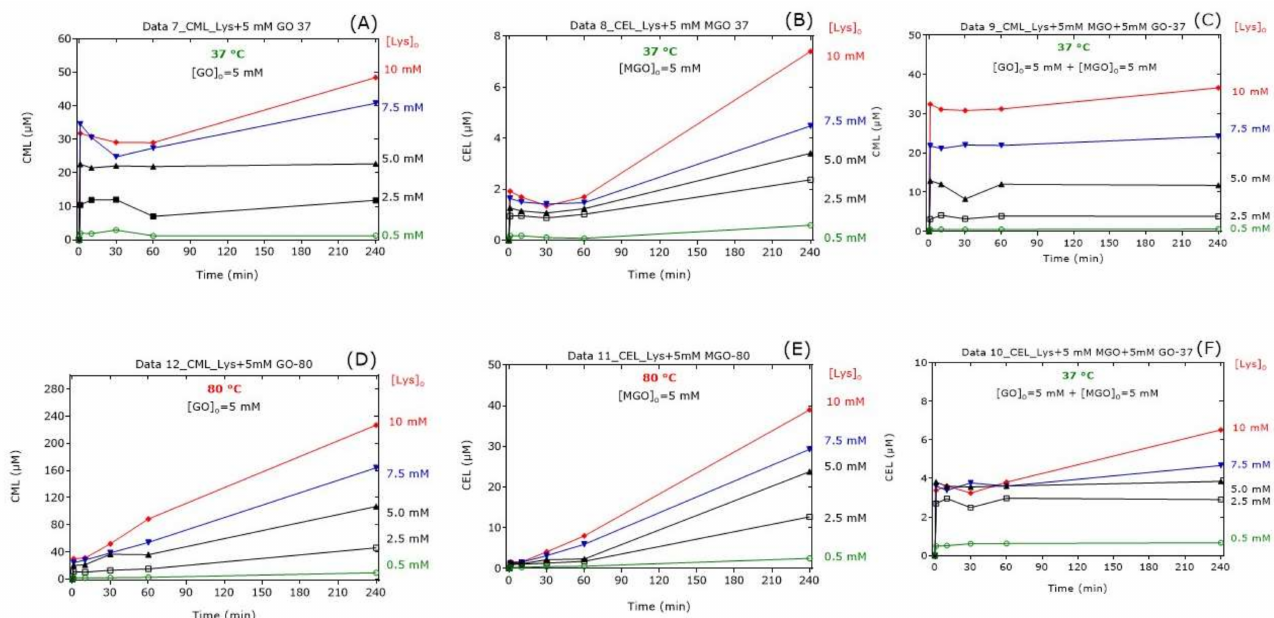
Figure 4. ( A – F ) Time-dependent formation of CML and CEL in reaction mixtures of Lys at the indicated concentrations of GO alone (5 mM), of MGO alone (5 mM) and of GO together with MGO (each at 5 mM) incubated at 37 ◦ C or 80 ◦ C. All experiments were performed in independent triplicates. For the sake simplicity, only the mean values are plotted. See also Tables